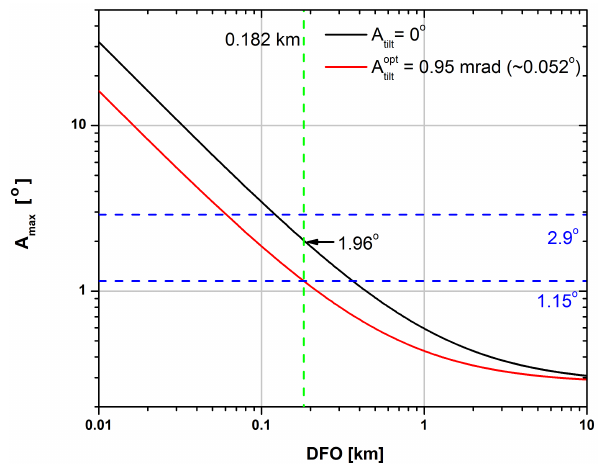
Figure 3. The variability of the maximum angle of incident rays on the IFF ( A max ) for different DFO values, without laser tilt ( A tilt = = 095mrad; red 0 0 ; black line) and with optimum laser tilt ( A opt . tilt line). The blue horizontal dashed lines correspond to the maximum acceptance angles (2.9 and 1.15 ◦ ) of two IFFs with bandwidths of 0.5 and 0.15nm respectively (see Appendix).